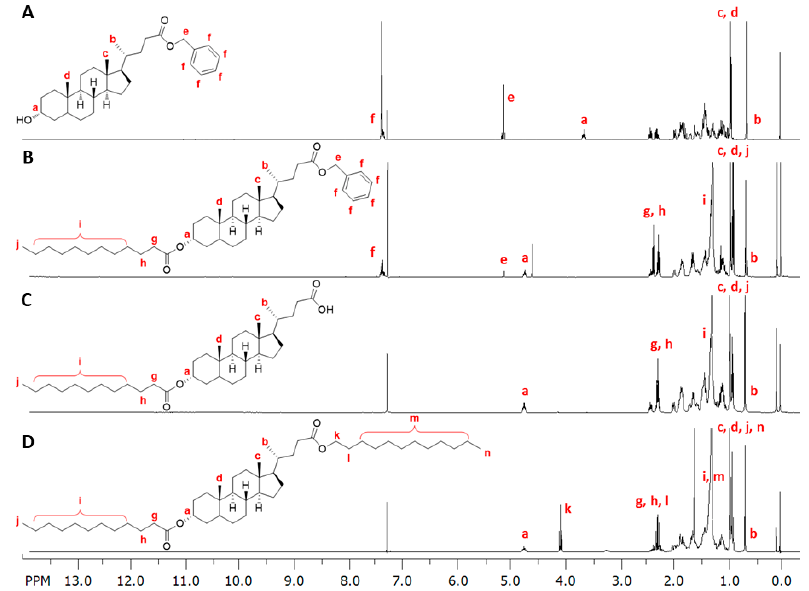
Figure 3. Sequential 1 H-NMR spectra in the synthesis of LCA-based hydrophobe. ( A ) benzyl lithocholate; ( B ) alkylated benzyl lithocholate; ( C ) monoalkylated LCA; ( D ) alkylated lithocholate.